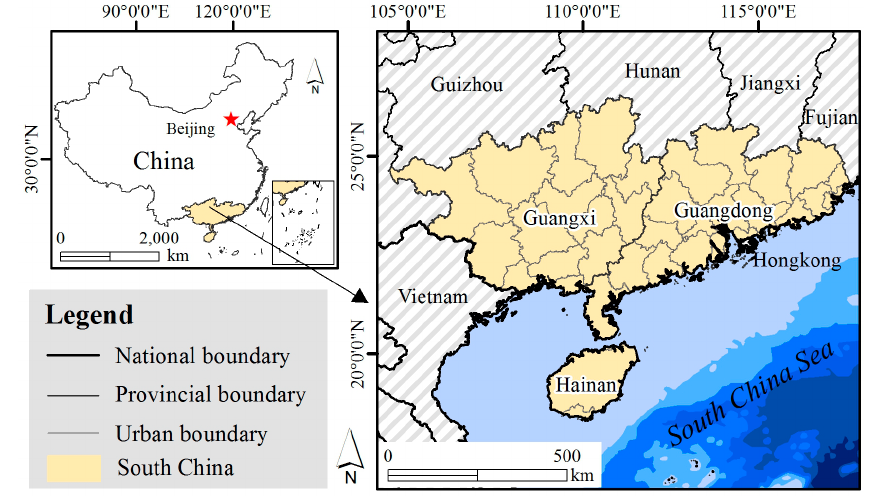
Figure 1. An overview of the South China study area.